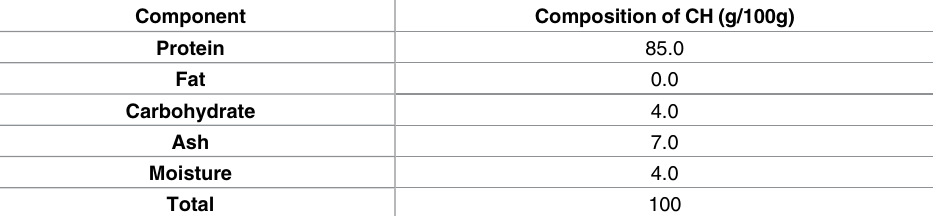
Table 1. Composition of